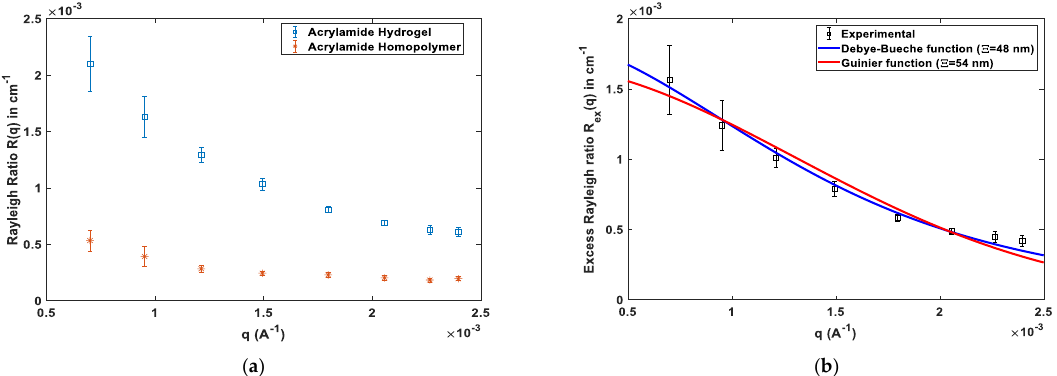
Figure 12. ( a ) Experimental data relative to the SLS analysis of a polyacrylamide hydrogel and the analogous polyacrylamide homopolymer (Rayleigh ratios at different scattering angles for H8 and L6). ( b ) Measured excess Rayleigh ratio for hydrogel H8 and data fitted using the Debye-Bueche and Guinier functions.